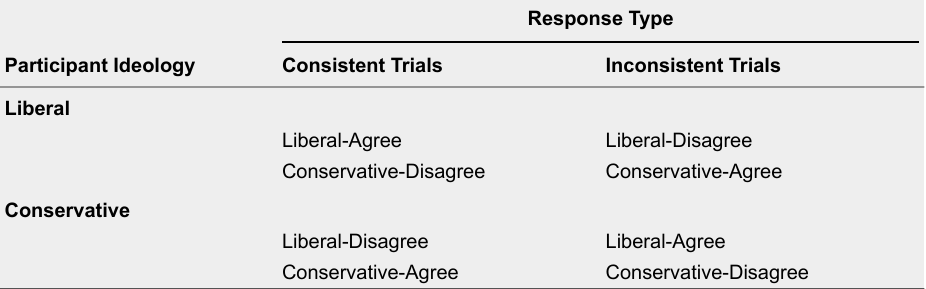
Coding of Consistent and Inconsistent Trials in the Task Facilitation